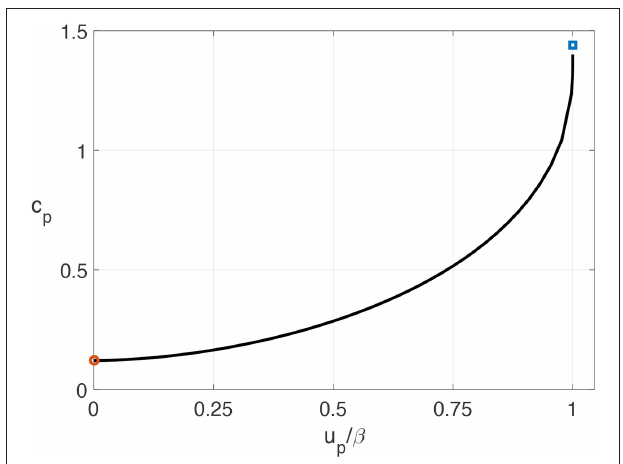
FIGURE 10 | The propagation speed c p corresponding to the preheated state u u p . The values of D 1 and A 2 are taken as an example. The solid line = = = represents the numerical simulation results in a one-dimensional medium described by Equation (5). The value of u ahead of the wave front is set to be u p . The open circle and square are the analytic results from Equations (20) and β , i.e., the resting state and the (21) at the limiting cases of u p 0 and u p = = excitation threshold,